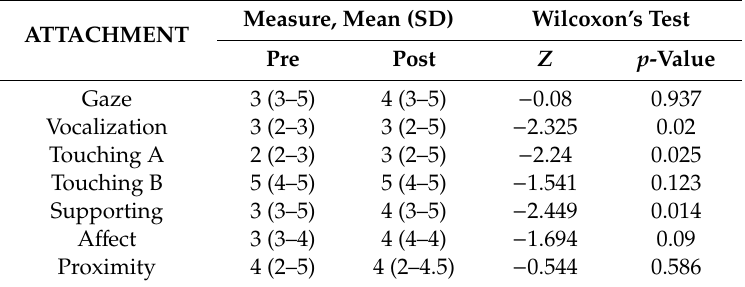
Table 3. Results of the attachment indicators for the casas